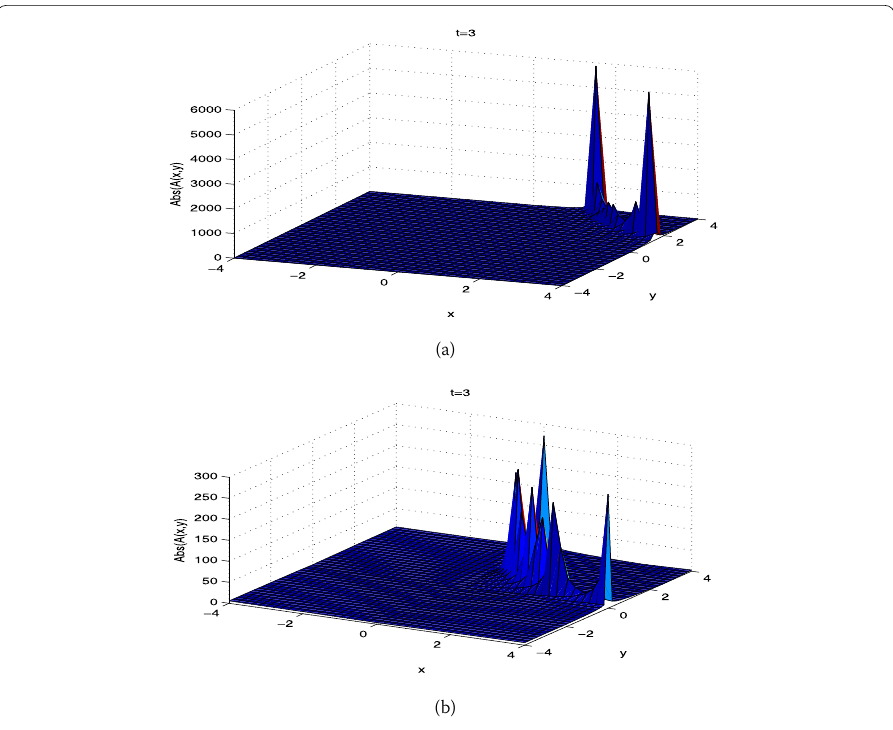
Figure 7 ( a ) The exact solution represented by Eq. (78), t = 3, α = 0.25, β = 0.25, γ = 0.25. ( b ) The exact solution represented by Eq. (78), t = 3, α = 0.5, β = 0.5, γ = 0.5